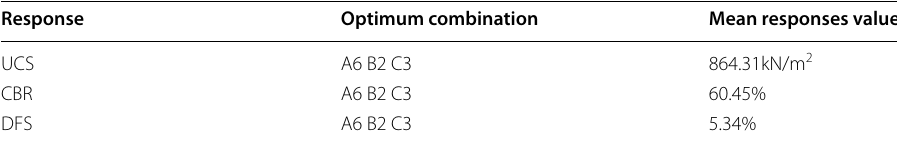
Table 11 Optimum combination of additives with their corresponding responses